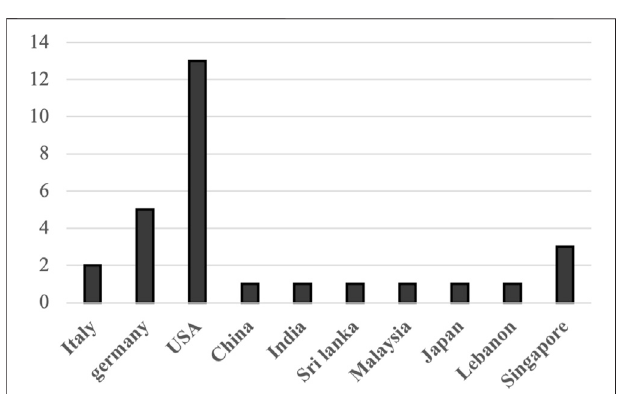
FIGURE 3 | The growing rate of published papers addressing our target topic over time.